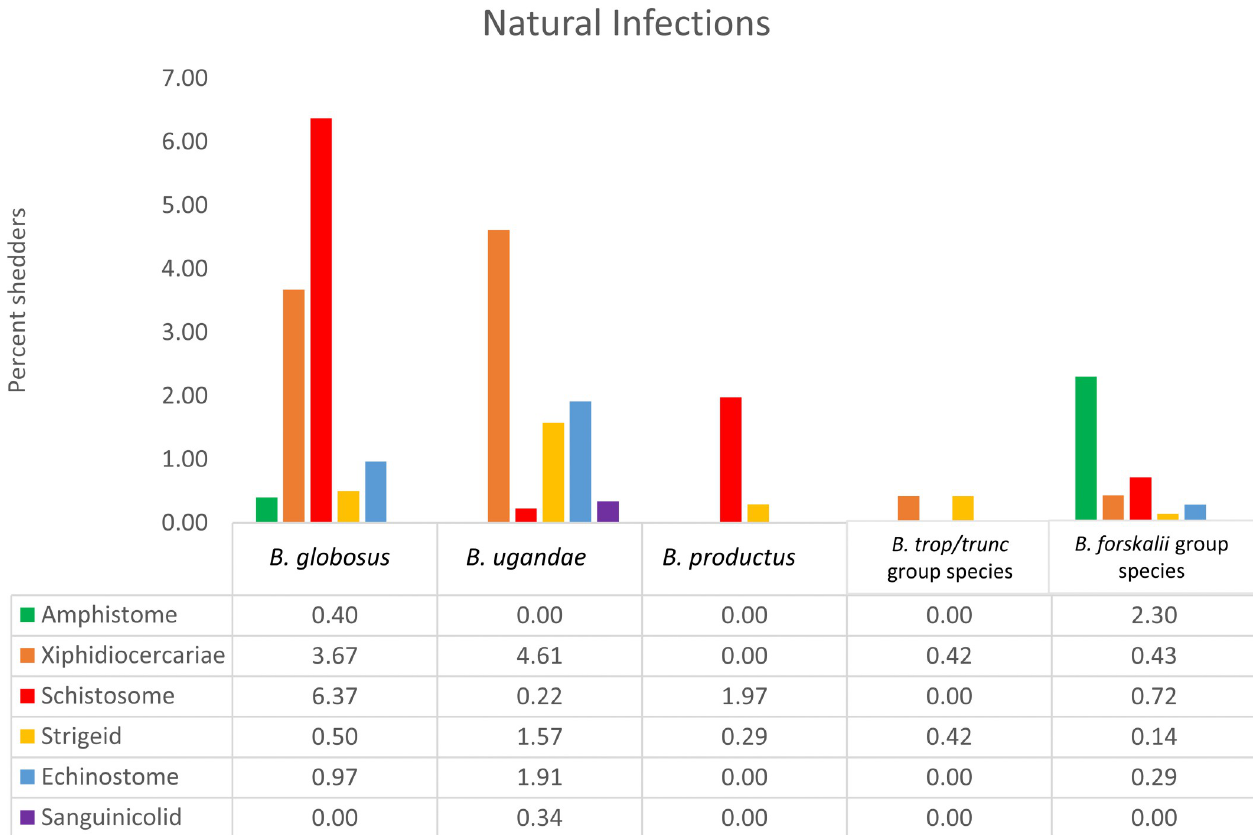
Fig 3. Prevalence of natural infections among field collected bulinids. Natural infection prevalence of 6 cercarial types shed from Bulinus snails collected between January 2014 and March 2021 from various localities in Kenya (S1 Table).